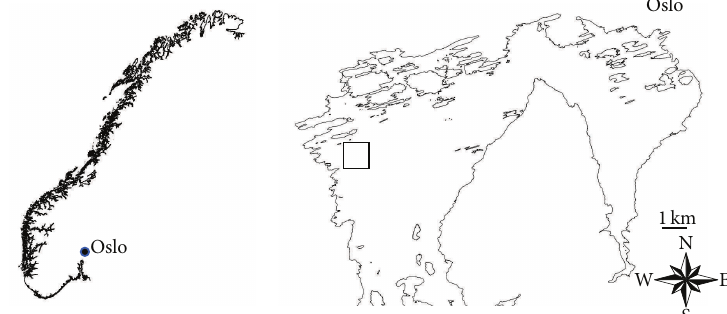
Figure 1: Map showing the location of the study area close to Oslo,